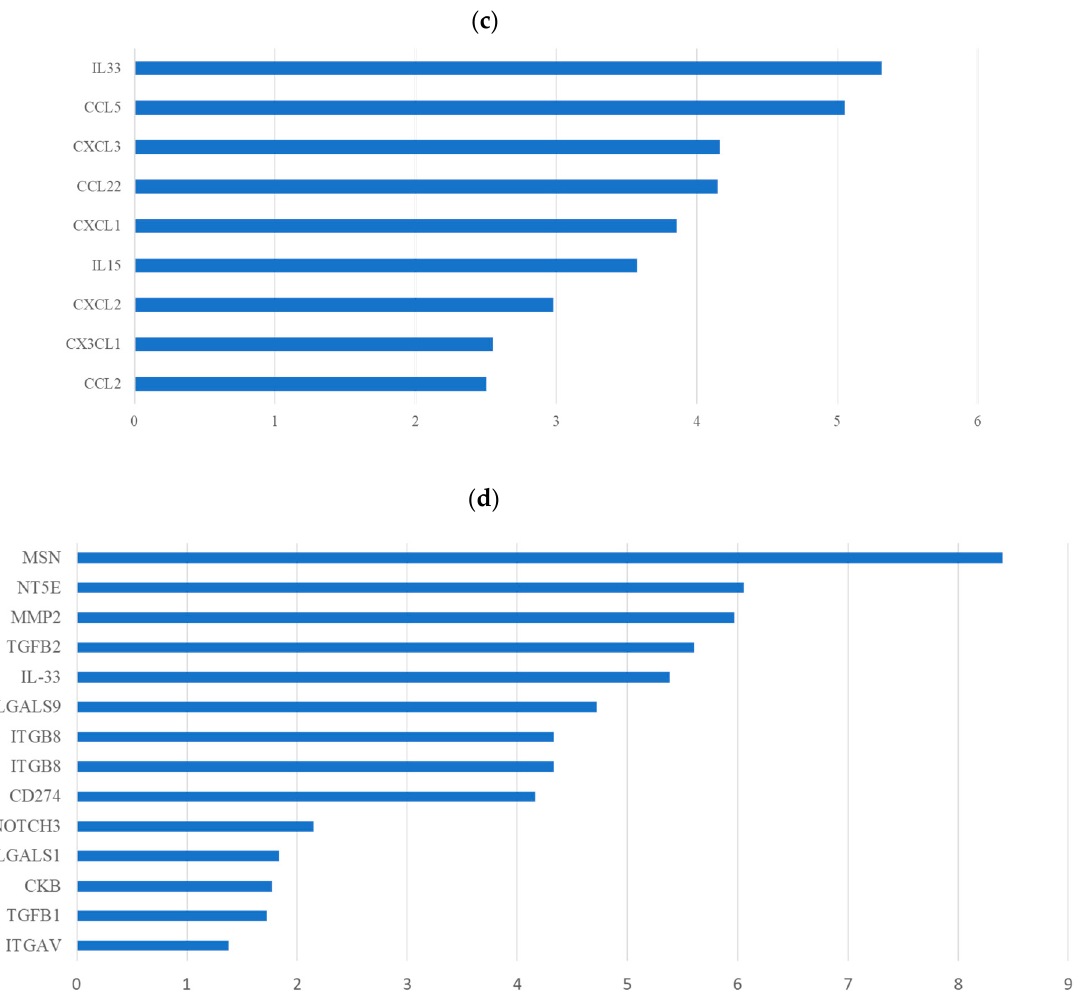
Figure 1. Representative molecular and genetic interrelation between triple-negative breast cancer (TNBC) cell lines (MDA-MB-231 and CAL-51) and luminal cell lines (ZR-75-1 and MCF7). ( a ) Enriched signaling pathways, ( b ) transcriptional regulation of upstream pathway, ( c ) cytokines and chemokine, and ( d ) genes significantly correlated with forkhead box P3 (FOXP3) in TNBC cell lines compared with the luminal cell lines. Each log 2 fold change value was ranked. The score was calculated based on hypergeometric distribution between the searched molecular network and the canonical pathway. * indicates significant pathway in TNBC compared to luminal subtype.